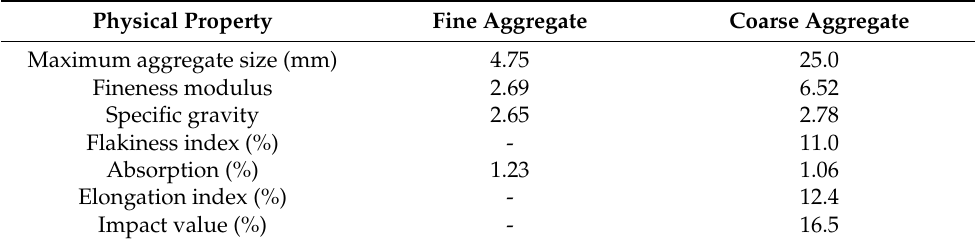
Table 1. Physical properties of fine and coarse